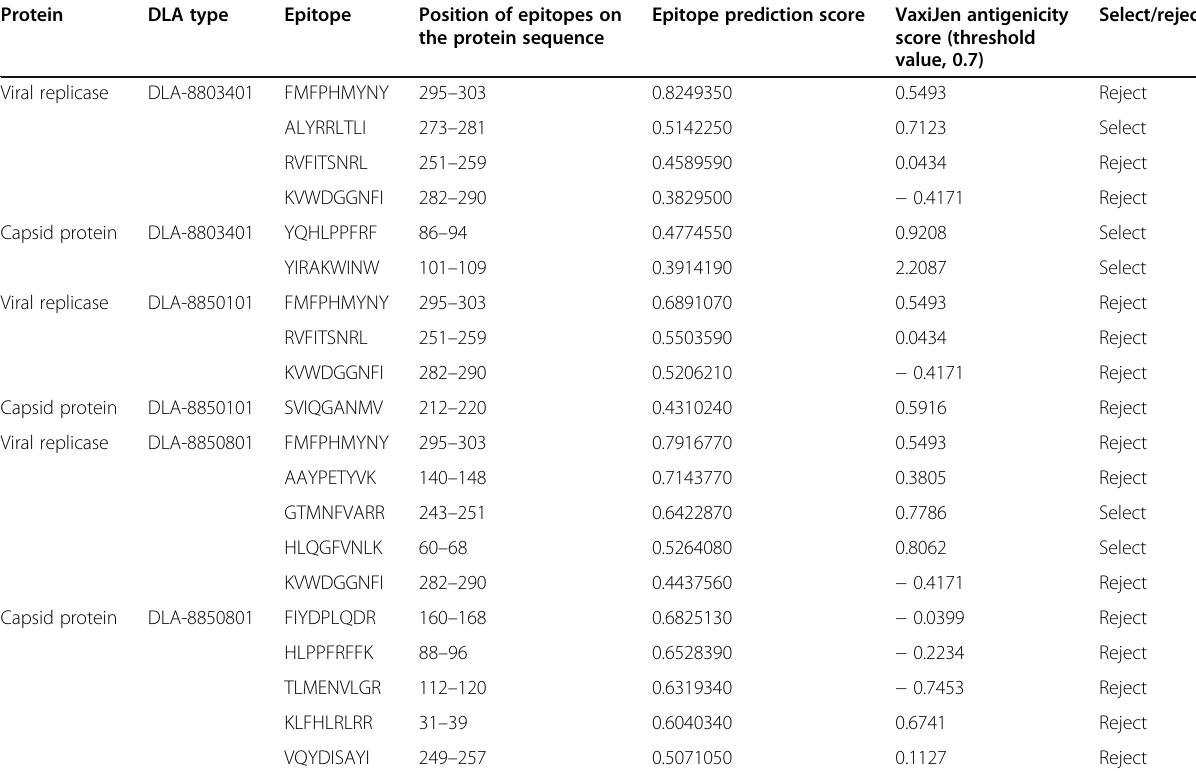
Table 2 Epitopes selection based on Epitope prediction score and antigenicity score Protein DLA type Epitope Position of epitopes on the protein sequence